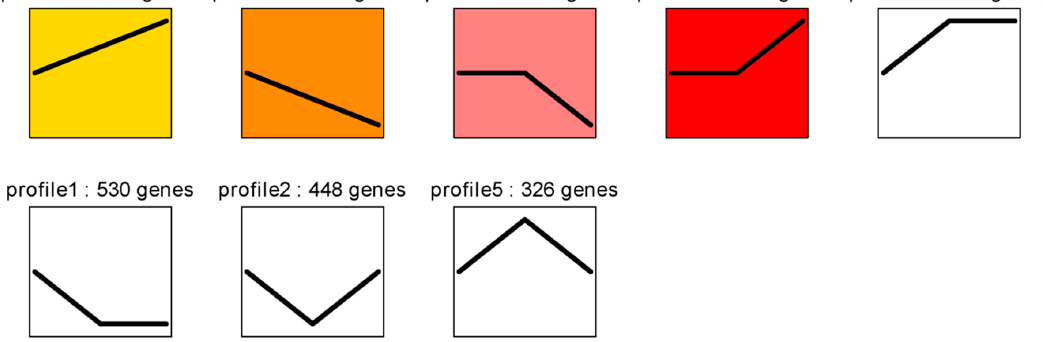
Figure 5. Eight profiles of DEGs with unique expression alterations over E13, E18, and E28. The profile number and the number of genes are shown on top of each square. The number of genes assigned is used to order the profiles. The profiles with color ( p < 0.05): significant enrichment trend. The profiles without color: non-significant enrichment trend.